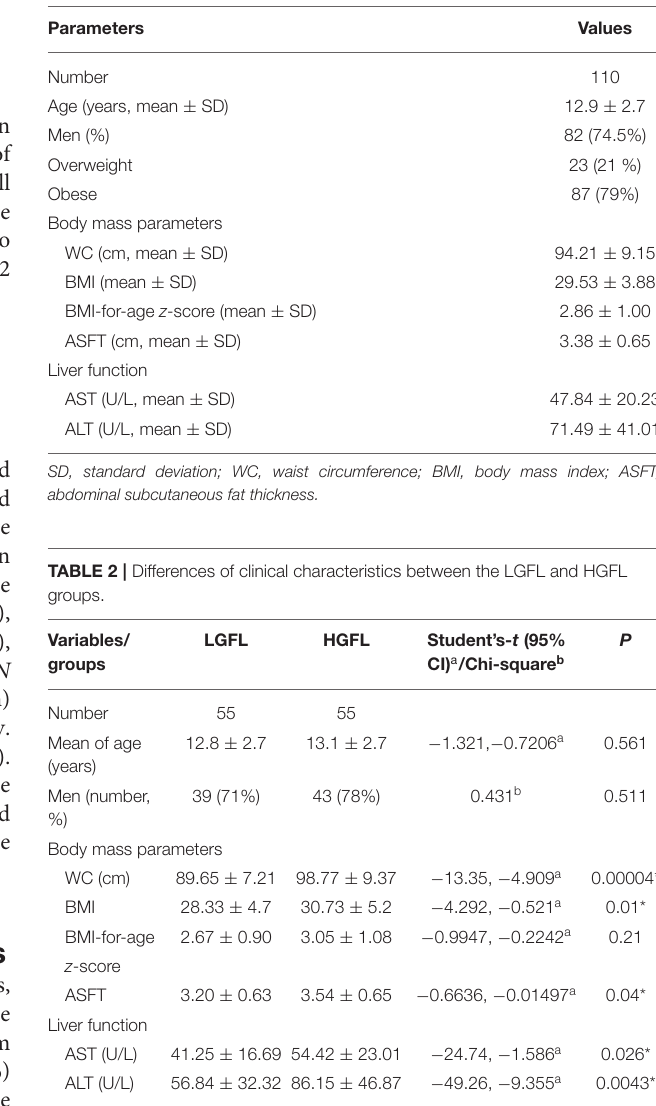
TABLE 1 | Demographics and clinical characteristics of enrolled patients.